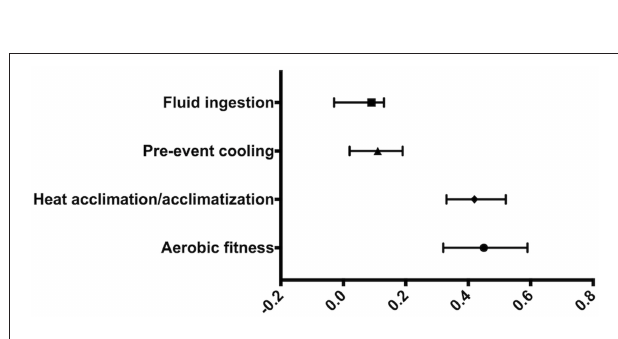
FIGURE 3 | Forest plot of combined Hedges’ g weighted averages of heat mitigation strategies.